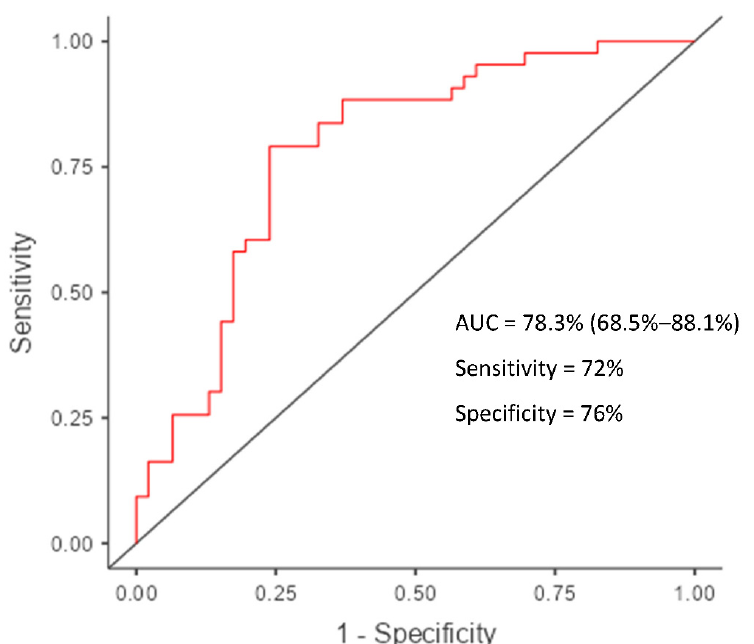
Figure 3. ROC curve for predicting myocardial iron overload (T2*Septal level 20) using a multiple logistic regression model with predictors Hb, LVEF, and RVGLS.